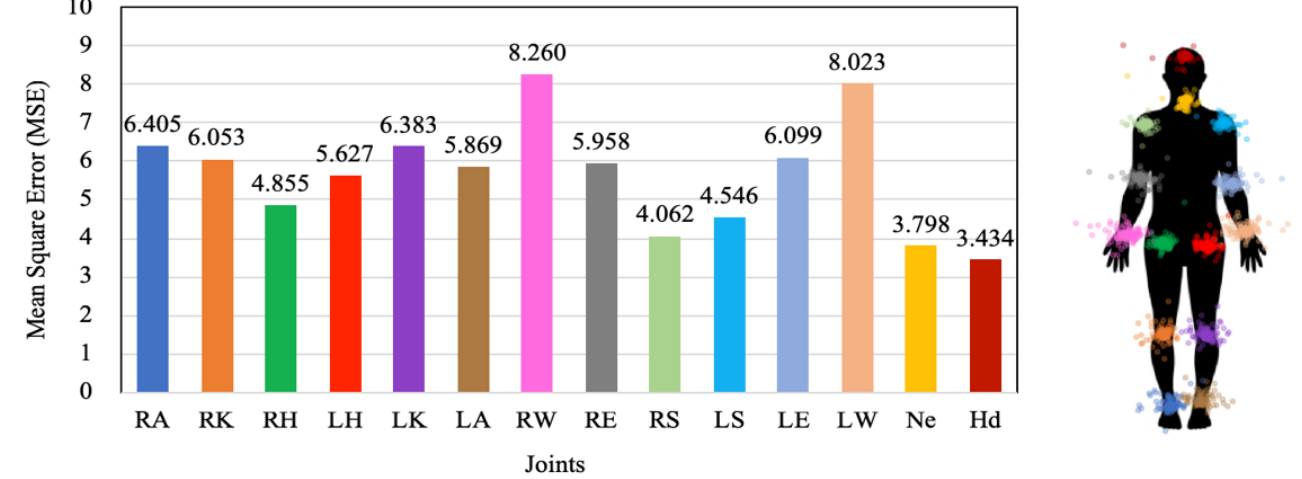
Figure 8. Mean squared errors (MSEs) of the estimated joints with the test dataset.